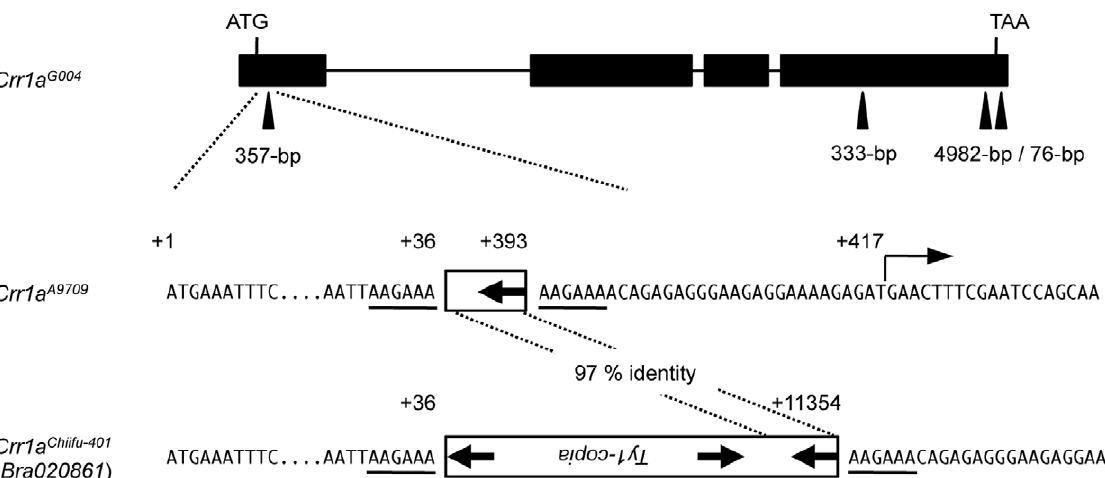
Figure 4. Sequence polymorphisms of Crr1a between resistant and susceptible alleles. Crr1a G004 : Schematic representation of Crr1a allelic structure in resistant G004. Black boxes, exons; black lines, introns; arrowheads, large insertions. Crr1a A9709 : Sequence surrounding the site of the 357- bp insertion in susceptible A9707. White box, retrotransposon-like sequence. Bent arrow, transcription start site of Crr1a A9709 predicted by 2 independent 5 9 -RACE analyses. Putative target site duplication is underlined. Crr1a Chiifu-401 : Corresponding sequence from susceptible Chiifu-401. The 357-bp insertion in Crr1a A9709 was almost identical to the 3 9 -terminal region of a 4546-bp copia -like retrotransposon found in Crr1a Chiifu-401 .